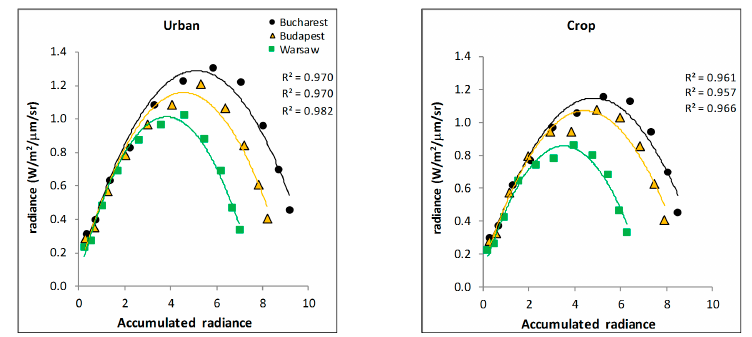
Figure 9. Fitted convex quadratic (CxQ) models for urban ( left ) and cropland ( right ) classes for Figure 9. Fitted Convex Quadratic (CxQ) models for urban ( left ) and cropland ( right ) classes for each city. each city. Table 2. Metrics characterizing the fitted curves of Figure 9: modeled annual peak MIR radiance (Peak Height: PH) and accumulated monthly MIR radiance at annual peak (Time to Peak: